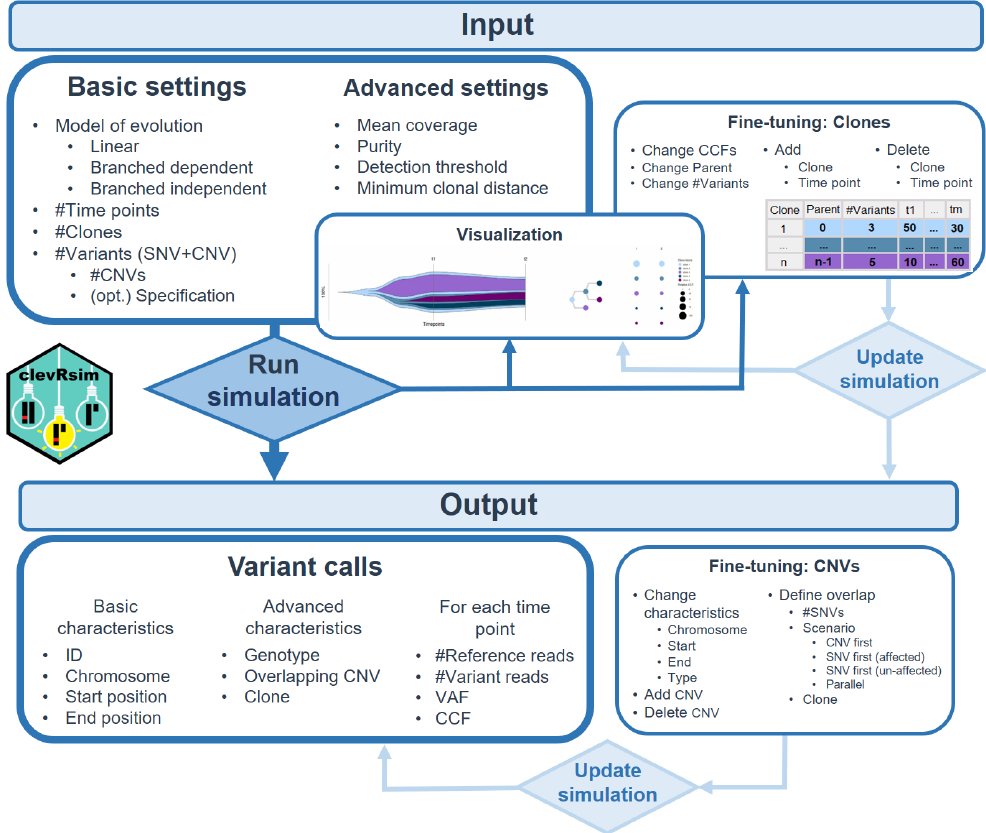
Figure 2. Overview of the simulation tool clevRsim. A graphical user interface is provided to generated customizable clonal evolution patterns. Basic information, including clones, their parents, and the cancer cell fraction at every time point, and a visualization of clonal evolution are provided. Additionally, variant calls—supporting SNVs as well as (overlapping) CNVs—are simulated. Output generated using clevRsim may serve as direct input for tools performing variant clustering and clonal evolution tree